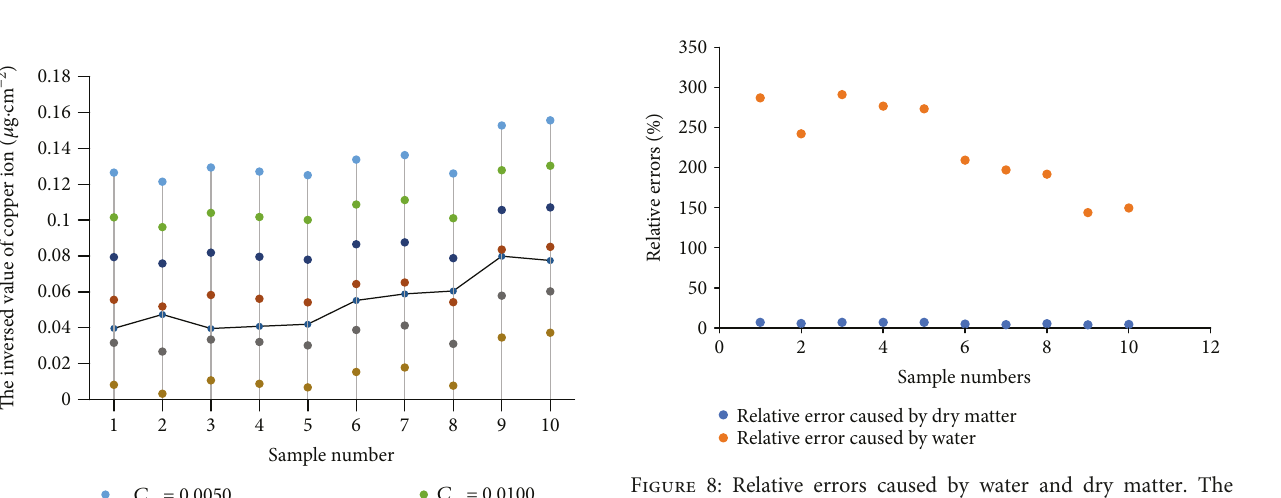
Figure 5: The uncertainty and sensitivity matrix.